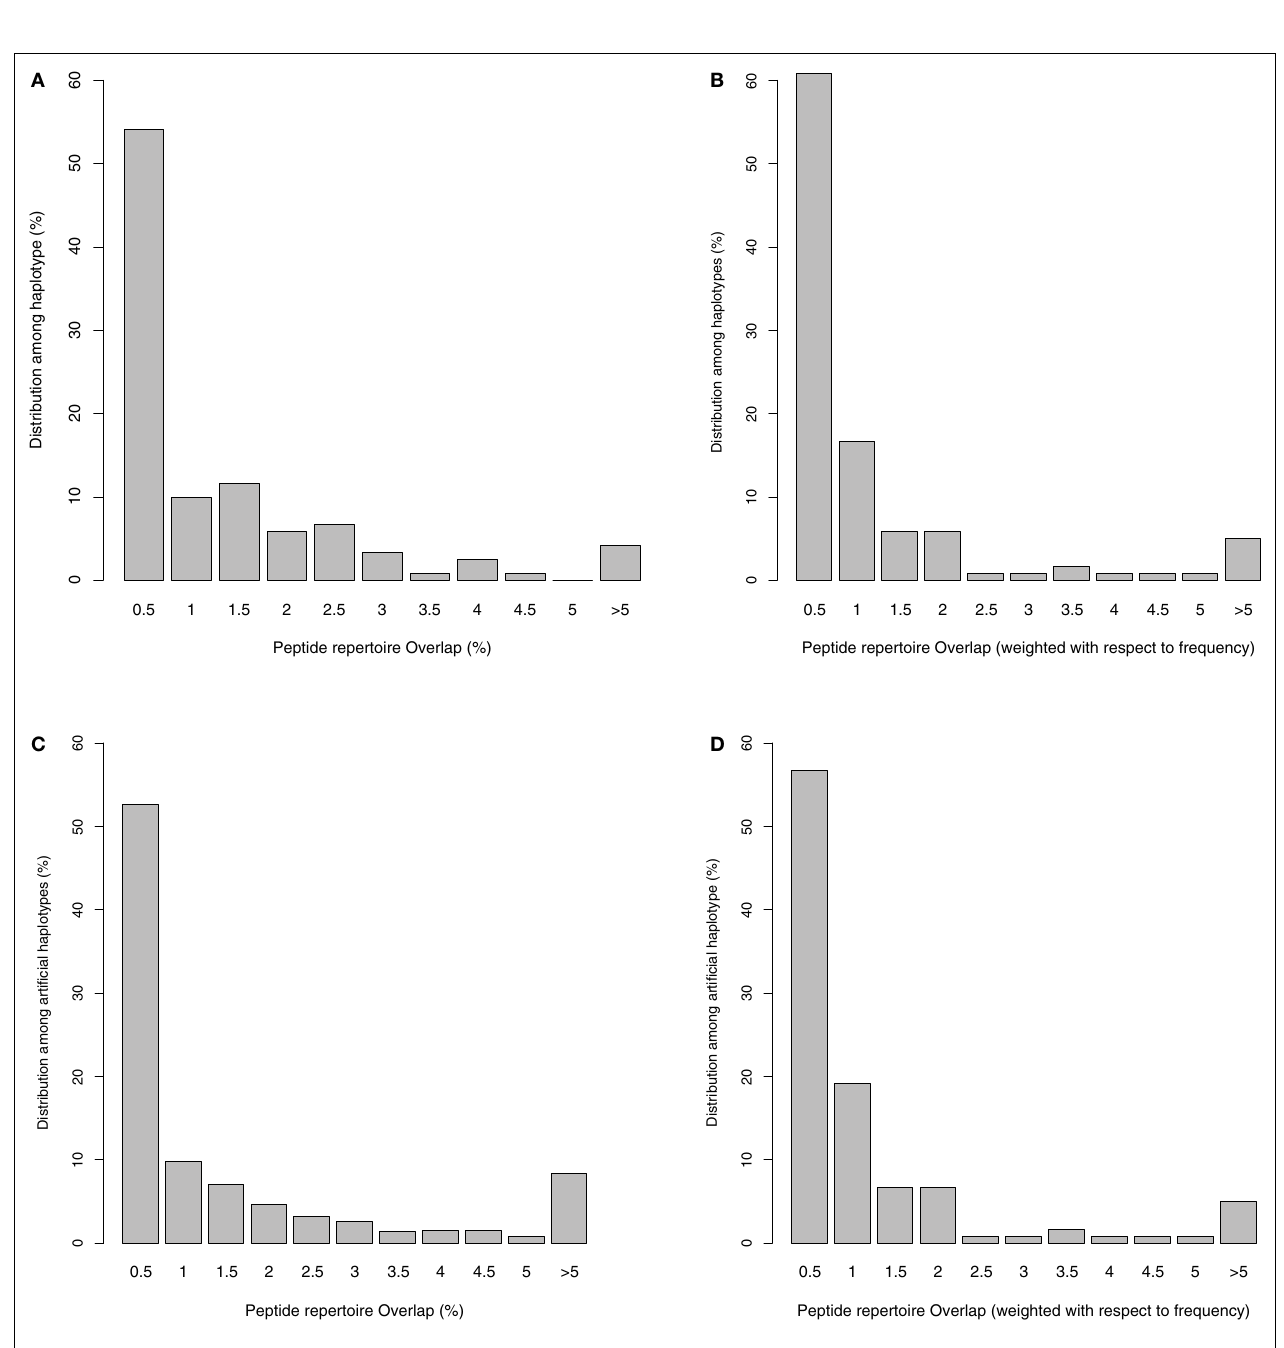
remains one. In (C) we plot the overlaps found in artificially generated haplotypes (created by reshuffling the HLA-A and -B molecules from the 120 unique haplotypes).This plot is representative of 100 sets of artificially generated haplotypes. (D) The weighted peptide overlaps for the artificial haplotypes, where we estimate the frequency of the haplotype as the multiplication of the frequency of HLA-A and HLA-B molecule in the population (normalized to let the sum of the frequencies of the artificial haplotypes remain